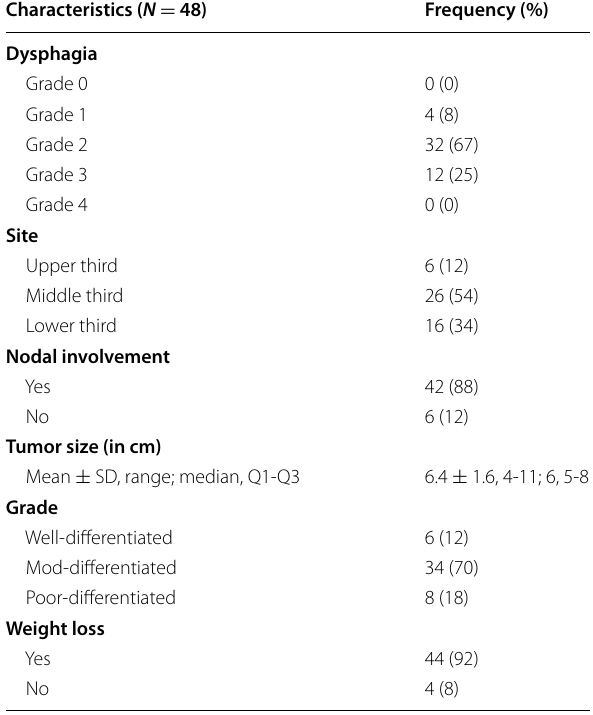
Table 2 Disease